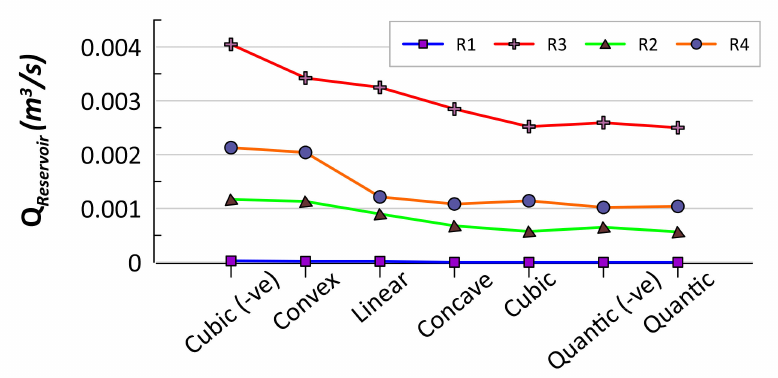
Figure 14. Overtopping rates at di ff erent